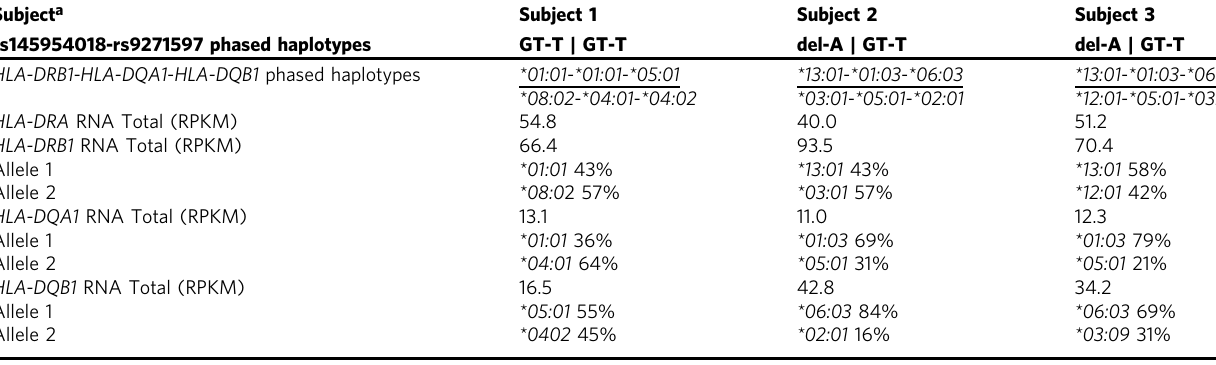
Table 2 Allele-speci fi c expression of HLA class II genes in whole blood cell